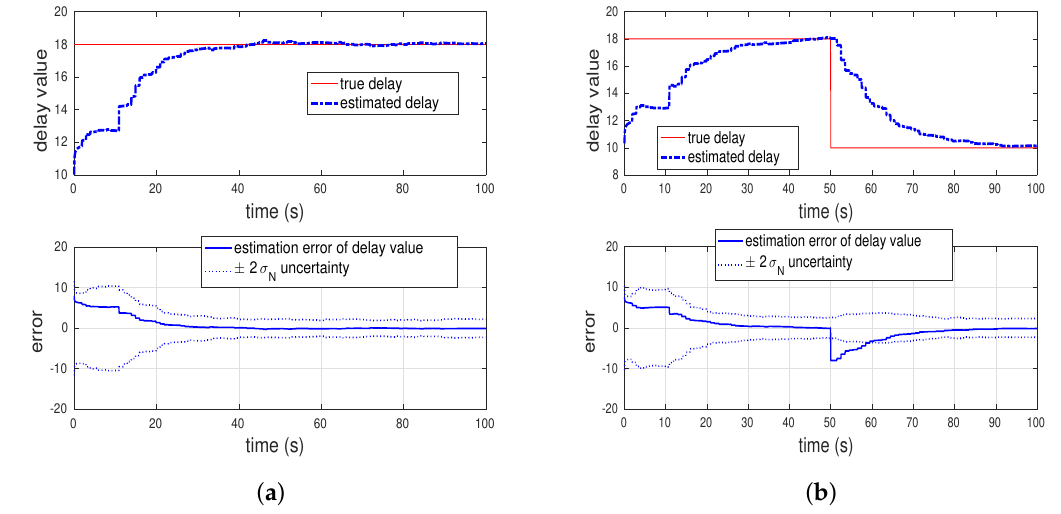
Figure 7. Estimation of total delays in simulation. ( a ) A static delay, ( b ) Varying